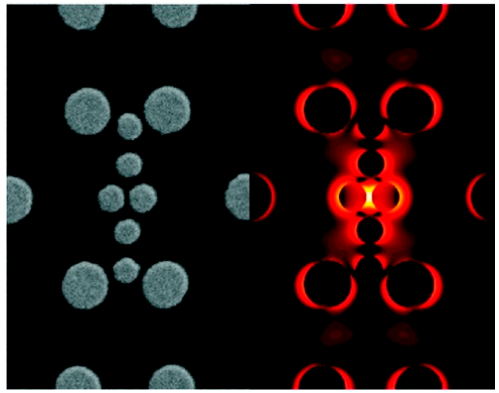
Figure 34. Genetically optimized array of nanoparticles: SEM image (left) and field localization (right). Reproduced with permission from Forestiere et al. [44]. Copyright (2012), the American Chemical Society.